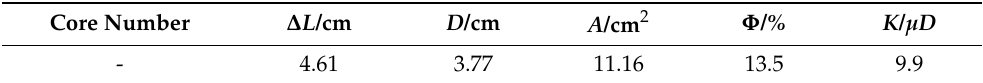
Table 6. Basic core data [31].